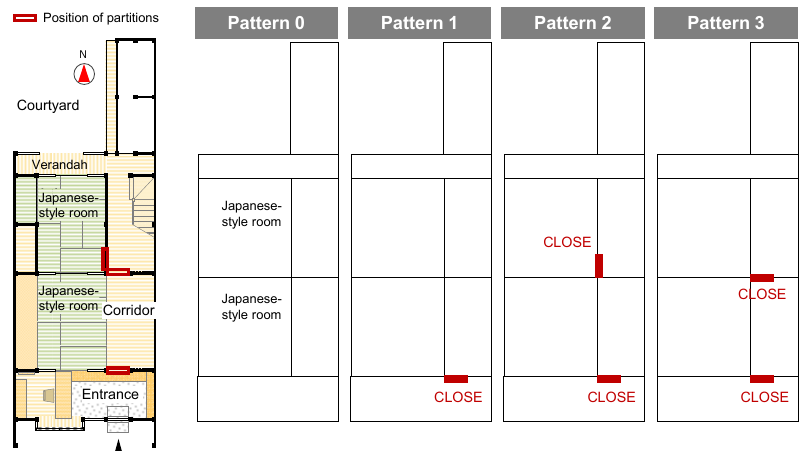
Figure 10. Closure of doors (Fusuma) in the model residence.